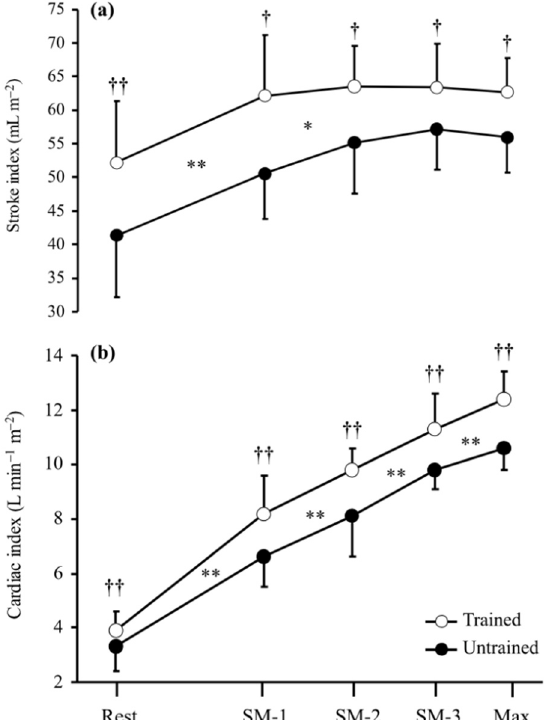
Figure 1. Stroke index ( a ) and cardiac index ( b ) at rest and during submaximal and maximal exercise in the child cyclists and untrained children. Difference between workloads for both groups (* p < 0.05 and ** p < 0.001). Difference between the child cyclists and the untrained children († p < 0.01 and †† p < 0.001). Nottin et al., 2002 [34]. Reprinted with permission from Nottin et al., [34], 2002, John Wiley and